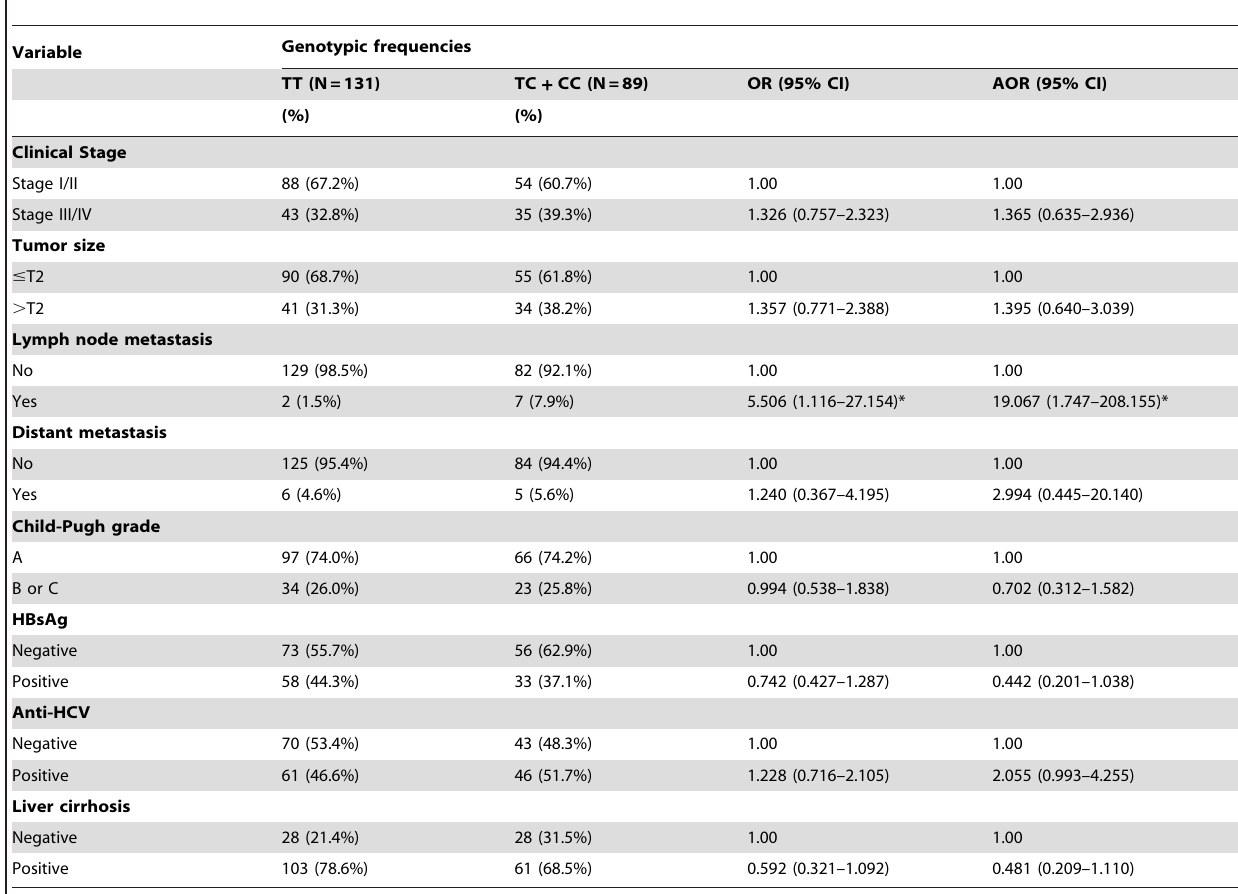
Table 4. Associations of clinical status and EZH2 rs3757441 genotypic frequencies in 220 HCC patients.